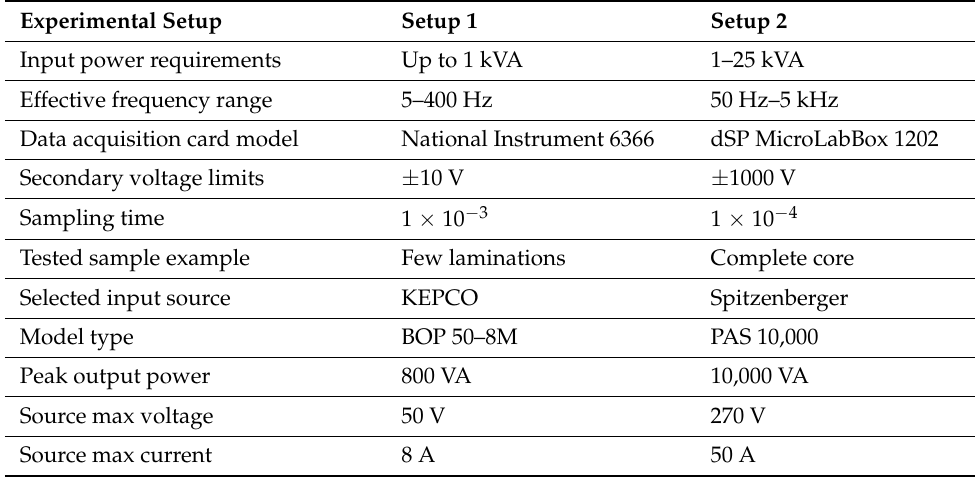
Table 2. Test setup specifications.